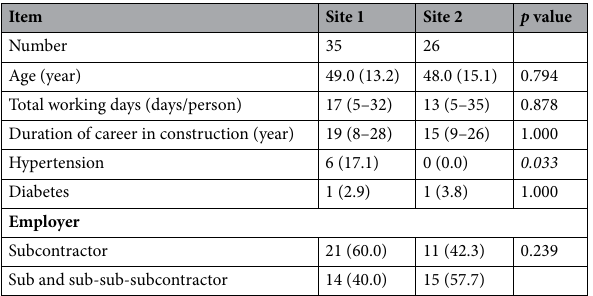
Table 1. Subject characteristics. Italic font describes significant difference ( p < 0.05). Mean (SD) or Median (25–75 percentile) or n (%). p value was calculated by Student’s t-test, Wilcoxon rank sum test, chi-square test, or Fisher’s exact test.